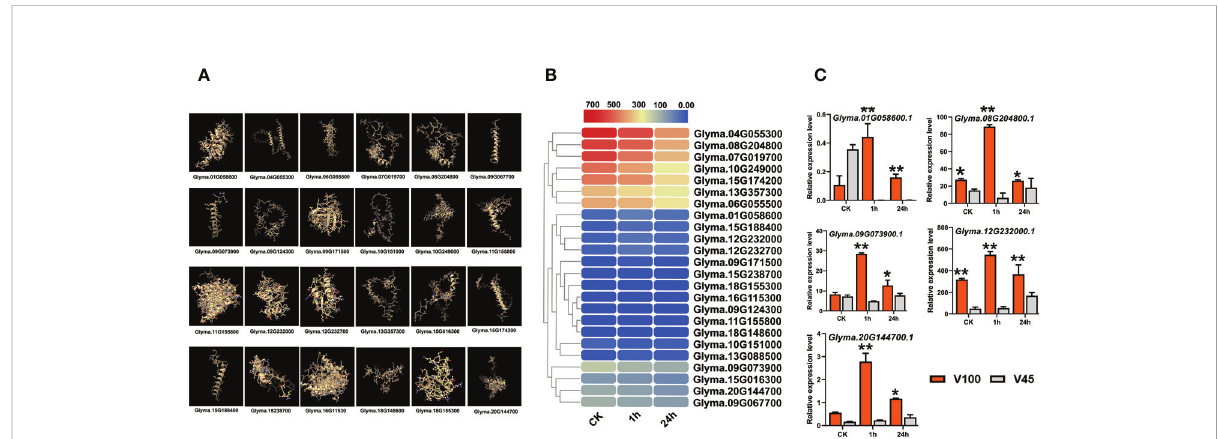
FIGURE 5 Protein structure and expression of photosynthesis related genes. (A) Predicted protein structure of photosynthesis genes, (B) RNA-seq expression analysis of photosynthesis genes under cold stress conditions, (C) qRT-PCR veri fi cation of photosynthesis genes in V100 and V45. Data was analyzed with the Statistix 8.1. The ** and * asterisks indicate the signi fi cant differences at p-value <0.01 and p-value <0.05, respectively.